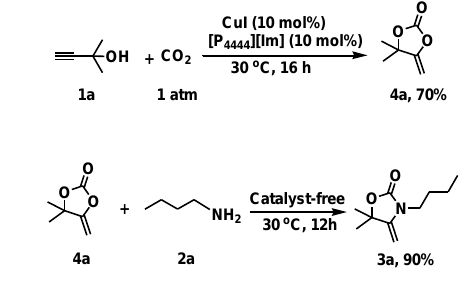
Scheme 2. Control experiments.